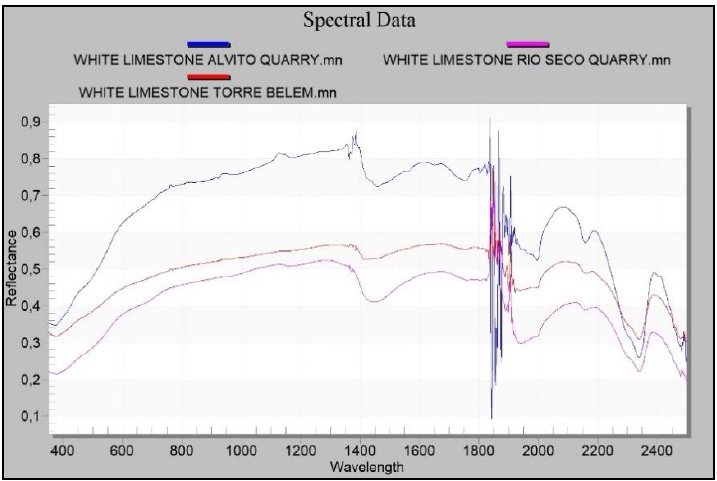
Figure 24. Spectral comparison between Lioz white limestone in the quarries and in the Tower of Belém. Evidence of spectral similarity of absorption peaks and slopes between the limestone at Tower of Belém (Red) and the limestone in Rio Seco Quarry (Purple).